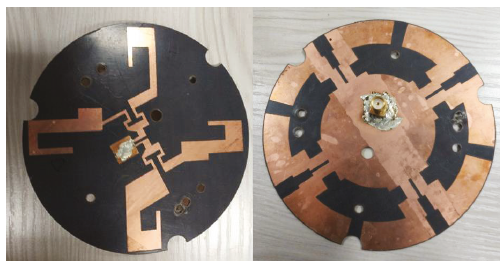
Figure 9: Prototype of the antenna system using the proposed DGS.